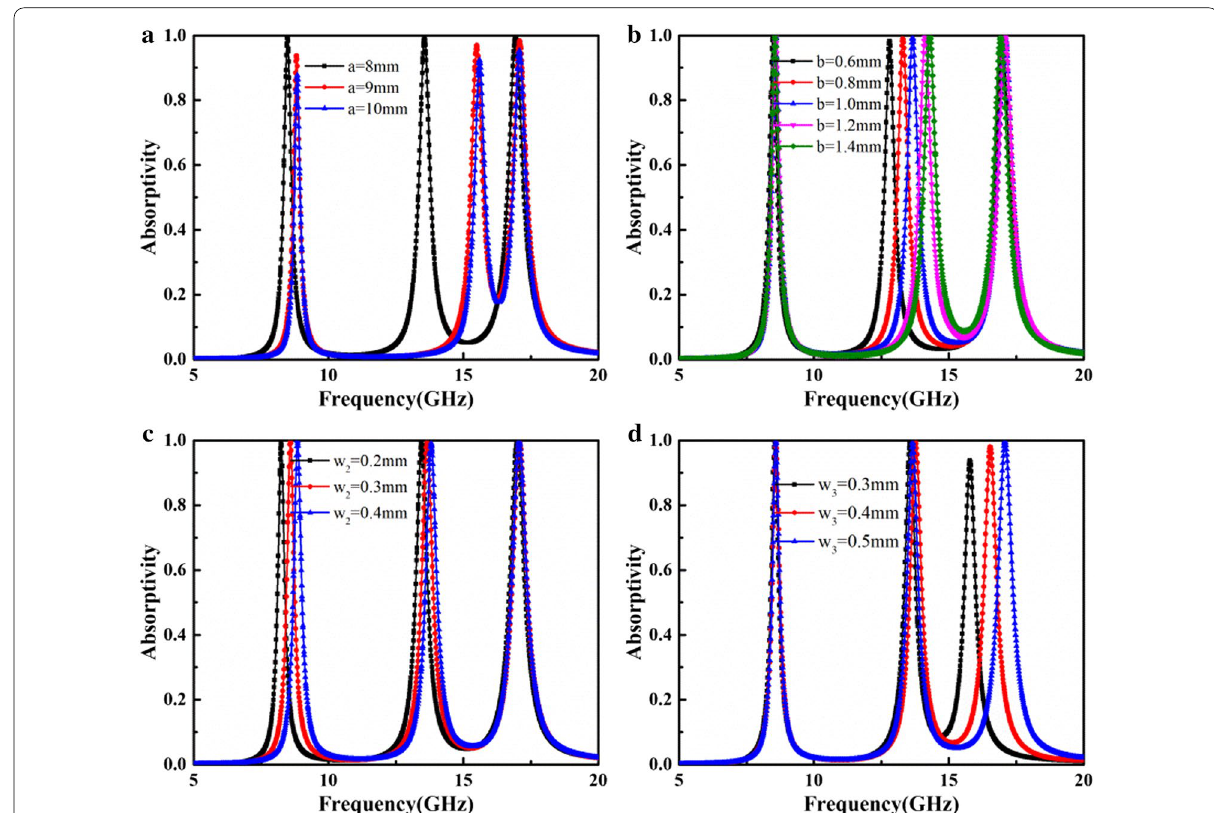
Fig. 6 Absorption spectrum of the MA for different structural parameters: a unit periodicity a , b SRR gap width b , c MSR ring bar width w 2 , d 7-shaped patch width w 3